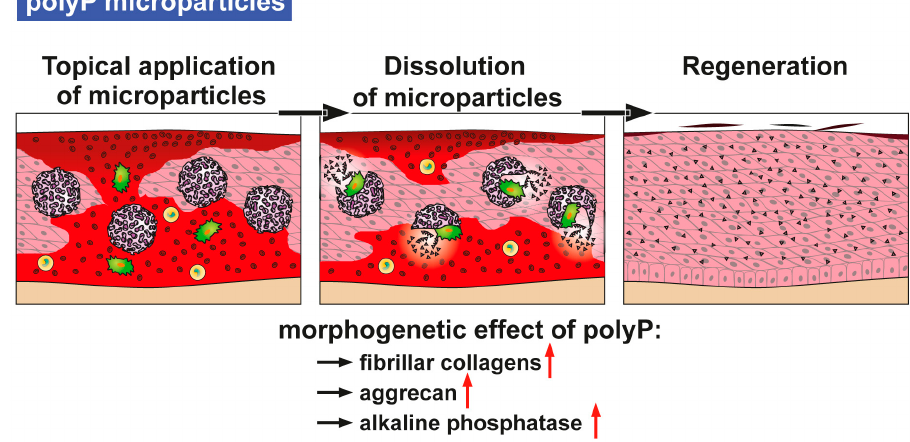
Figure 2. Proposed action mode of polyP, in the form of polyP microparticles, as a morphogenetically active and wound-healing-promoting physiological inorganic polymer. After topical application of the polyP microparticles (with collagen as host and polyP as guest) they undergo dissolution in the impaired tissue, as a result of ALP enzymatic hydrolysis. Then, polyP is known to activate the genes e.g., those encoding fibrillar collagens, aggrecan and the ALP. The experimental data given verify that these polyP microparticles accelerate wound healing and tissue regeneration. 2. Materials and Methods